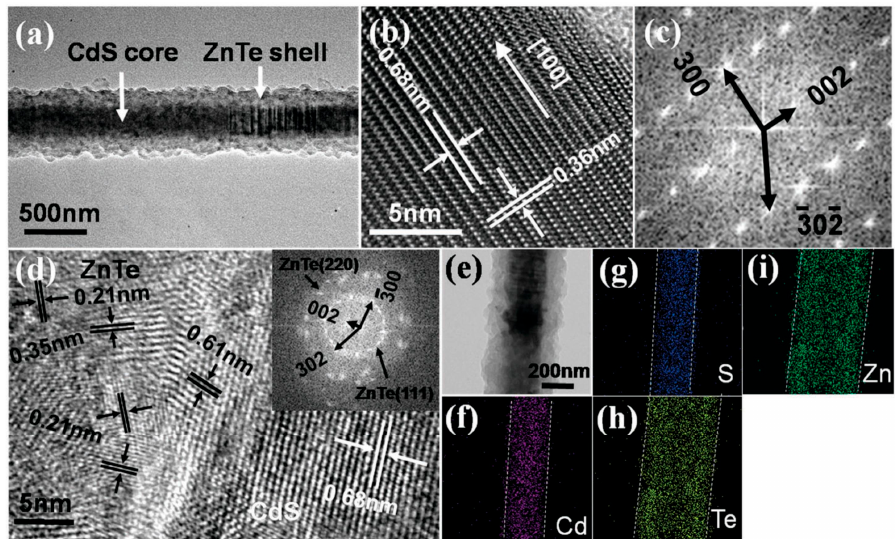
Figure 1. ( a ) TEM image of a CdS-ZnTe core-shell nanowire. ( b ) HRTEM image of the CdS nanowire; and ( c ) the corresponding FFT pattern. ( d ) High-magnification TEM image of a CdS-ZnTe core-shell nanowire. ( e – i ) TEM image of an individual core-shell nanostructure and the corresponding elemental mapping images for: Cd ( f ); S ( g ); Te ( h ); and Zn ( i ). Reproduced with permission from [25], Copyright 2015, The Royal Society of Chemistry.